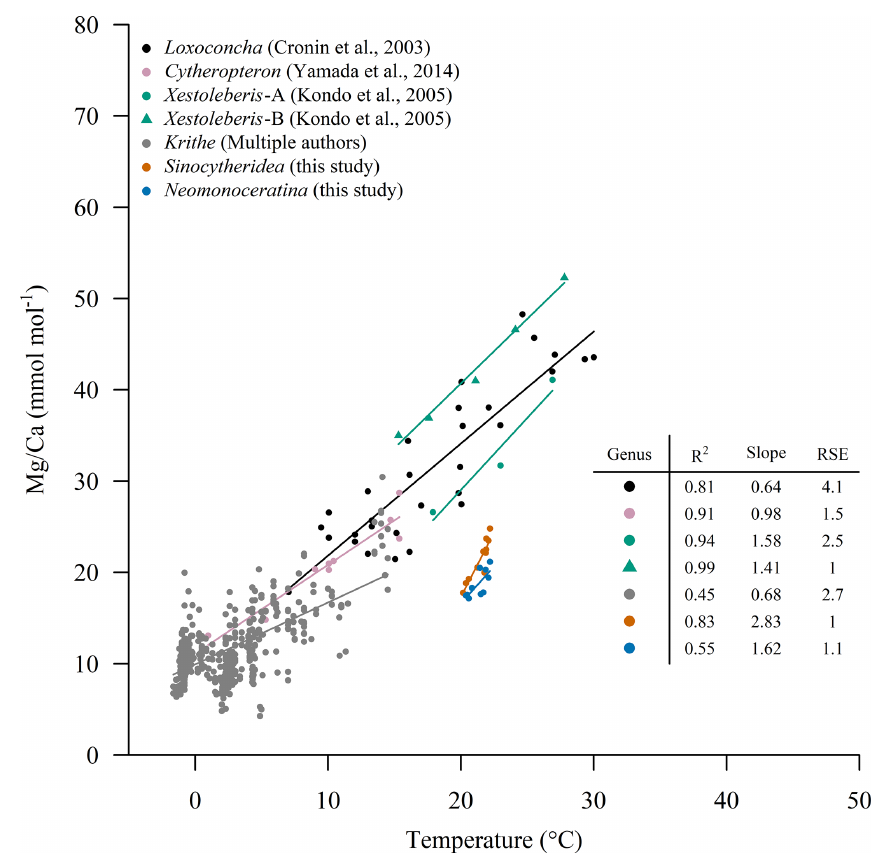
Figure 6. Temperature versus Mg / Ca ratios for specimens of the superfamily Cytheroidea. Krithe samples were retrieved from Farmer et al. (2012) and the study of Elmore et al. (2012) which contains the collection of Mg / Ca and BWT from different studies including Cadot and Kaesler (1977), Corrège and De Deckker (1997), Dwyer et al. (1995), Cronin et al. (1996), and Dwyer et al.